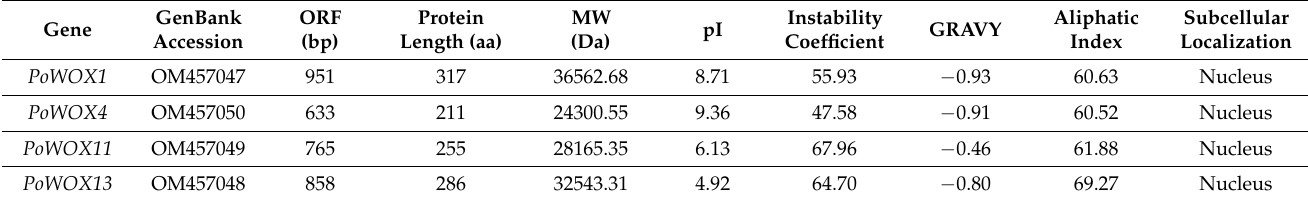
Table 6. Basic physicochemical properties of PoWOX